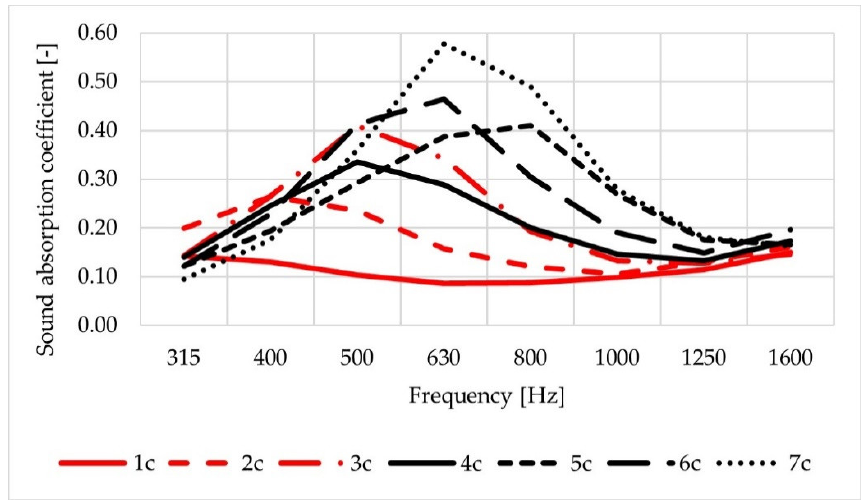
Figure 10. Average values of sound absorption coefficient obtained for the cylindrical specimens.